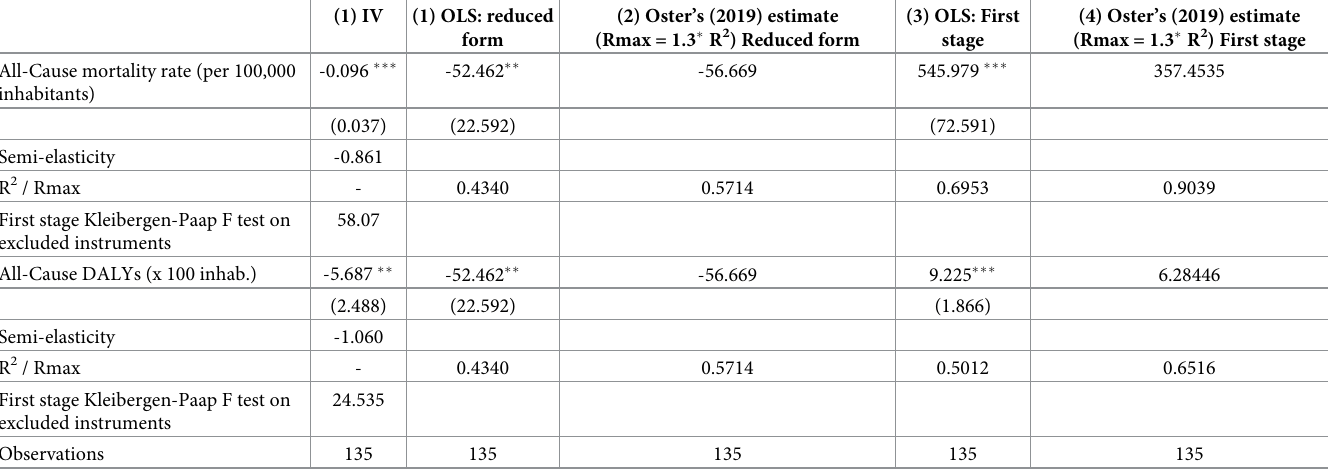
Table 3. The effect of mortality/DALYs on GDPpc growth. Reduced form and first